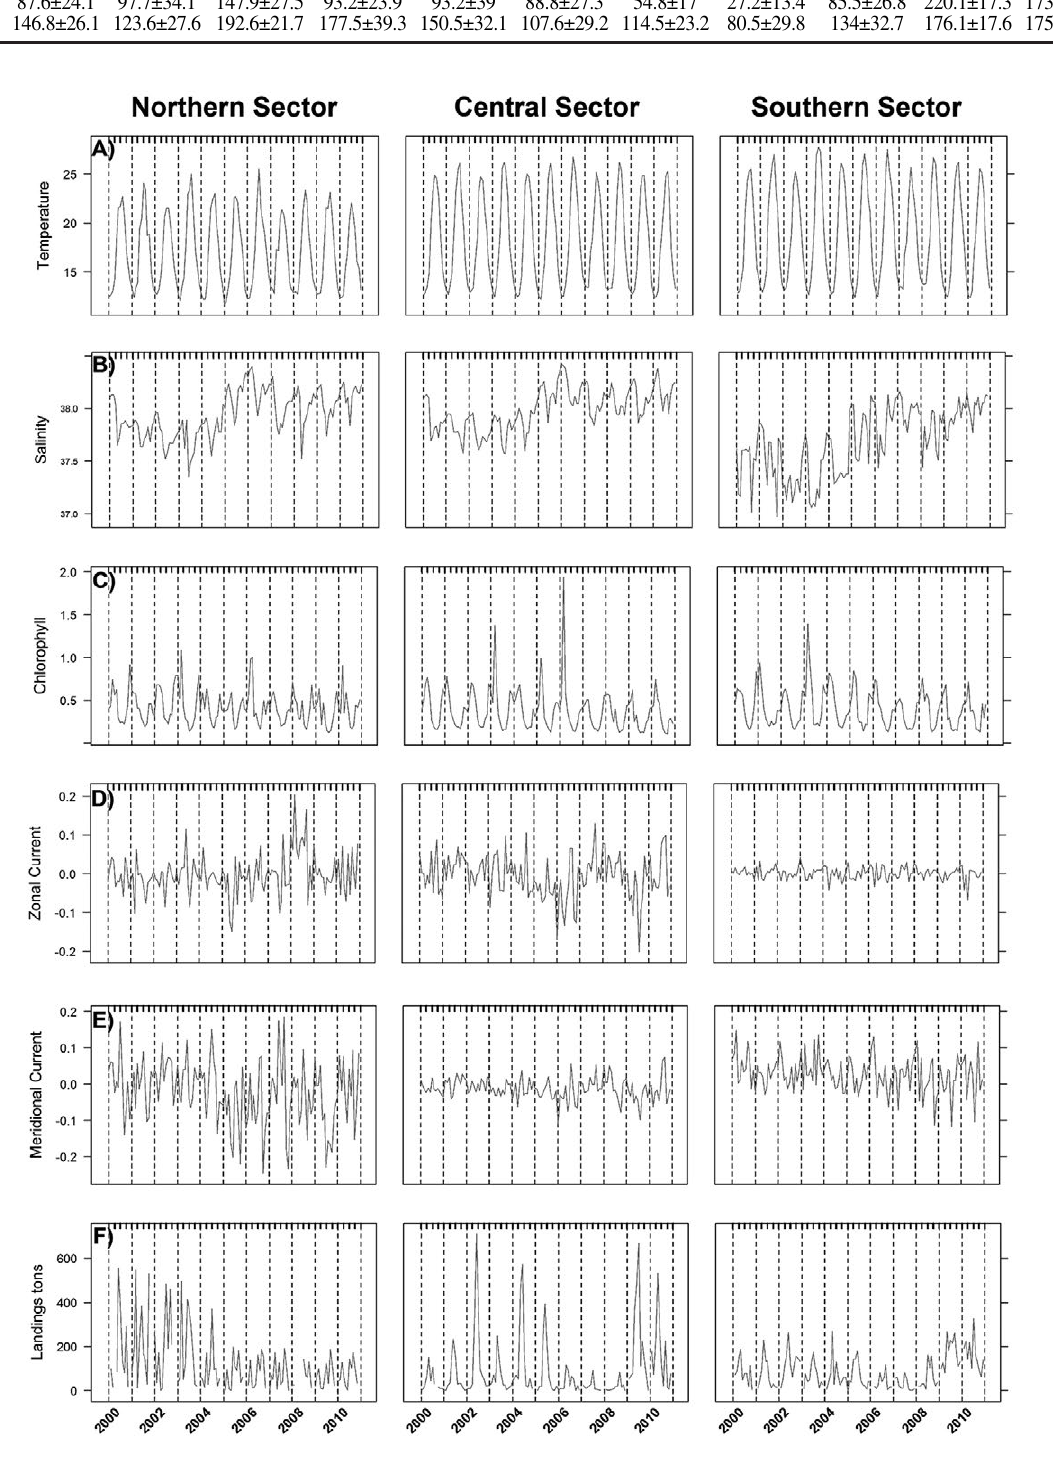
Fig. 3. – Series of monthly values (mean) for each sector. A, the sea surface temperature (SST); B, sea surface salinity (SSS); C, chlorophyll; D, meridional current; E, zonal current; F, anchovy landings during the years 2000-2010. Top ticks indicate the seasons of the year. Note missing data in winter due to the annual close season to protect anchovy recruitment (usually December and